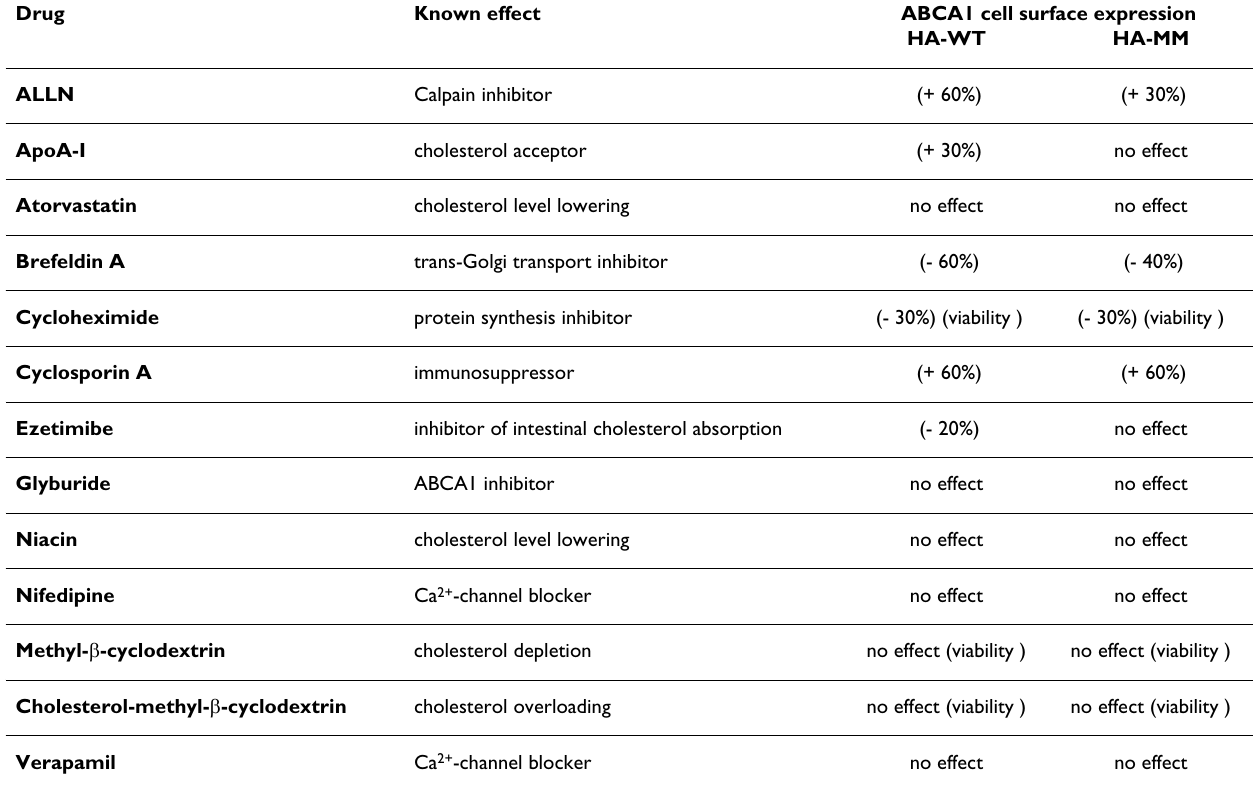
Table 1: Effect of various substances on the cell surface expression of wild type (HA-WT) and mutant (HA-MM) HA-ABCA1 variants Drug